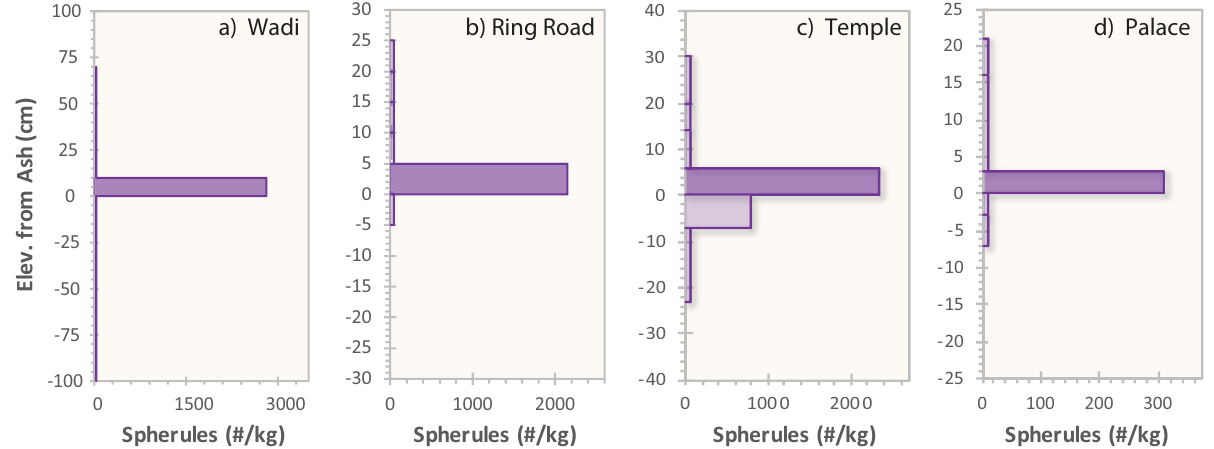
Figure 24. Spherule abundances. ( a )–( d ). Number per kg for Fe- and S-rich spherules from 4 locations. Depths are in cm above or below the bottom of the destruction